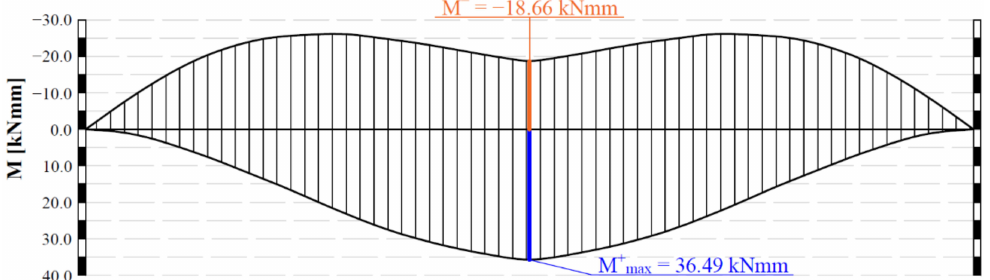
Figure 4. Bending moment envelope from FEM